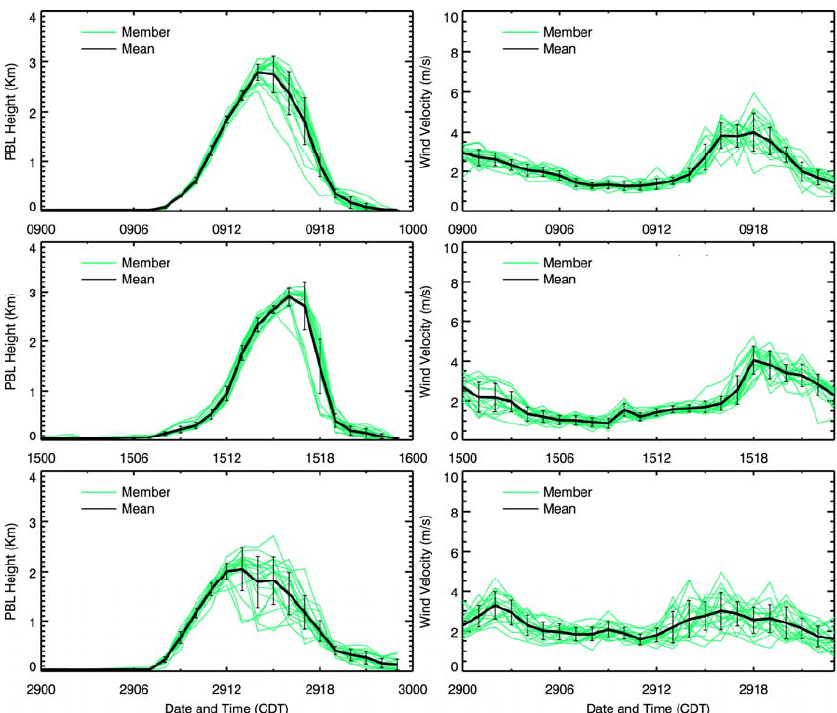
Fig. 14. Temporal evolution of the PBL height and surface wind speed from each ensemble member (thin green lines) and ensemble mean on different days (9, 15, and 29